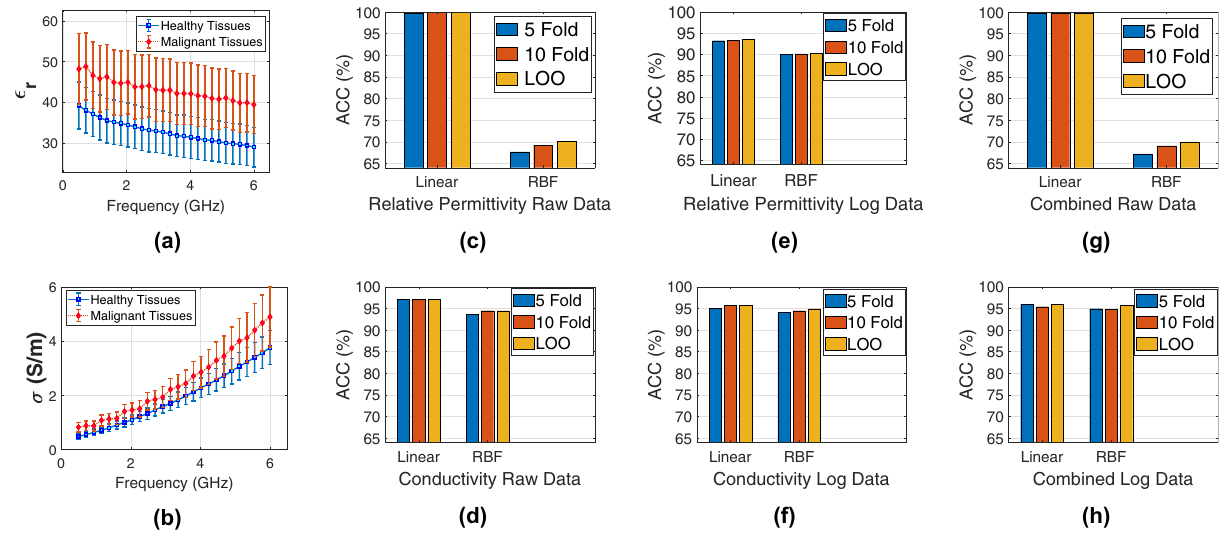
Figure 1. Classification results of the rat mammary carcinoma using three datasets derived from the microwave in vivo dielectric properties from 0.5 to 6 GHz. ( a ) Measured mean relative permittivities along with standard deviation from the mean (std) of healthy and malignant rat mammary tissues. ( b ) Measured mean conductivities along with std of healthy and malignant rat mammary tissues. ( c ) Classification accuracy (ACC) comparison of the Support Vector Machines (SVM) algorithm with linear and Radial Basis Function (RBF) kernels applied to raw relative permittivity data using different cross-validation (CV) schemes. ( d ) ACC comparison of the SVM algorithm with linear and RBF kernels applied to raw conductivity data using different CV schemes. ( e ) ACC comparison of the SVM with linear and RBF kernels applied to logarithm of the relative permittivity data using different CV schemes. ( f ) ACC comparison of the SVM algorithm with linear and RBF kernels applied to logarithm of the raw conductivity data using different CV schemes. ( g ) ACC comparison of the SVM with linear and RBF kernels applied to raw complex relative permittivity (combined) data using different CV schemes. ( h ) ACC comparison of the SVM with linear and RBF kernels applied to logarithm of the complex relative permittivity (combined) data using different CV